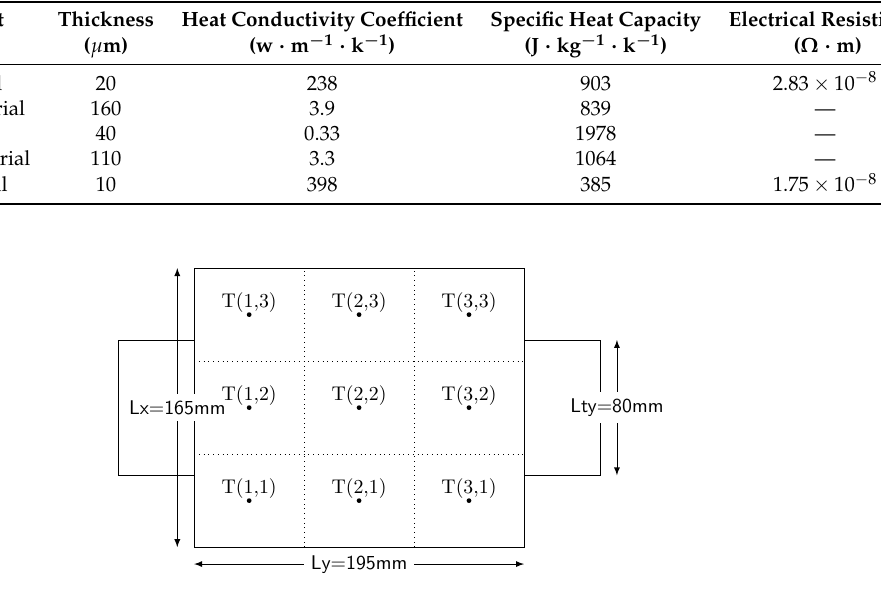
Figure 1. Cell dimensions and thermocouple